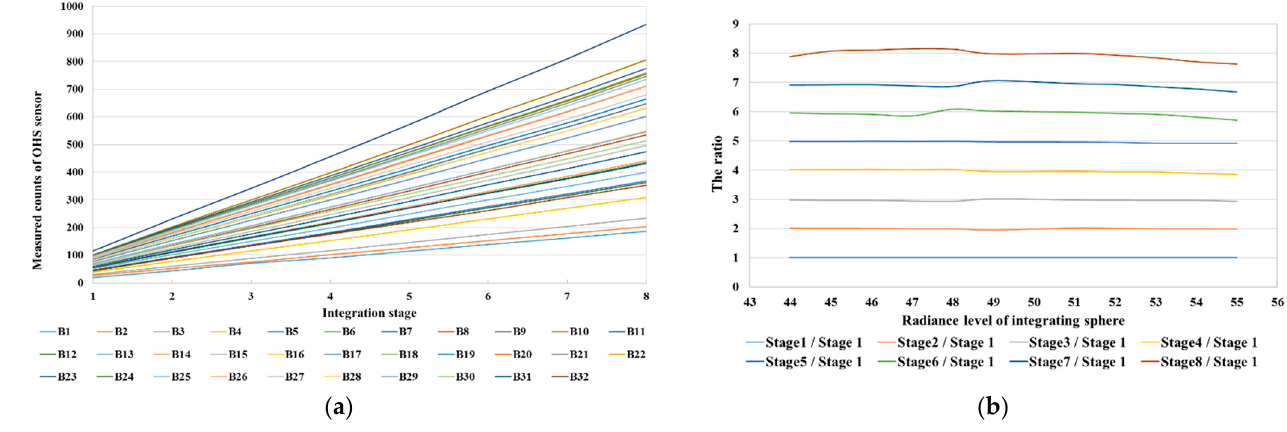
Figure 7. Laboratory test results regarding the relationship between the measured counts of OHS and integration stages. ( a ) The change in the measured counts of OHS when the integration stage varied; ( b ) the ratio between the measured counts at different integration stages (B3).